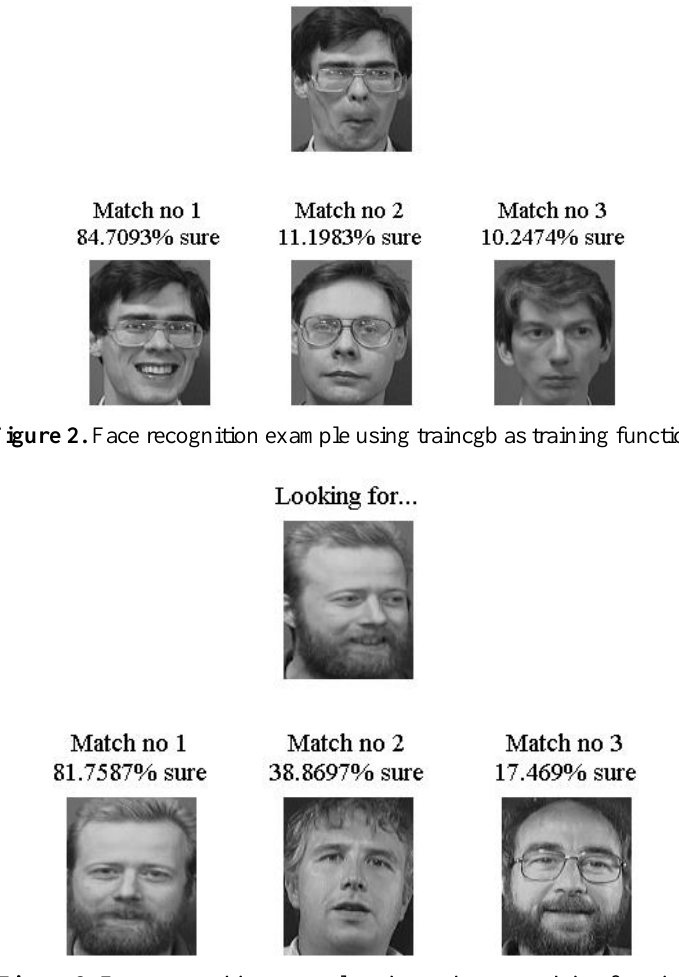
Figure 3. Face recognition example using trainrp as training